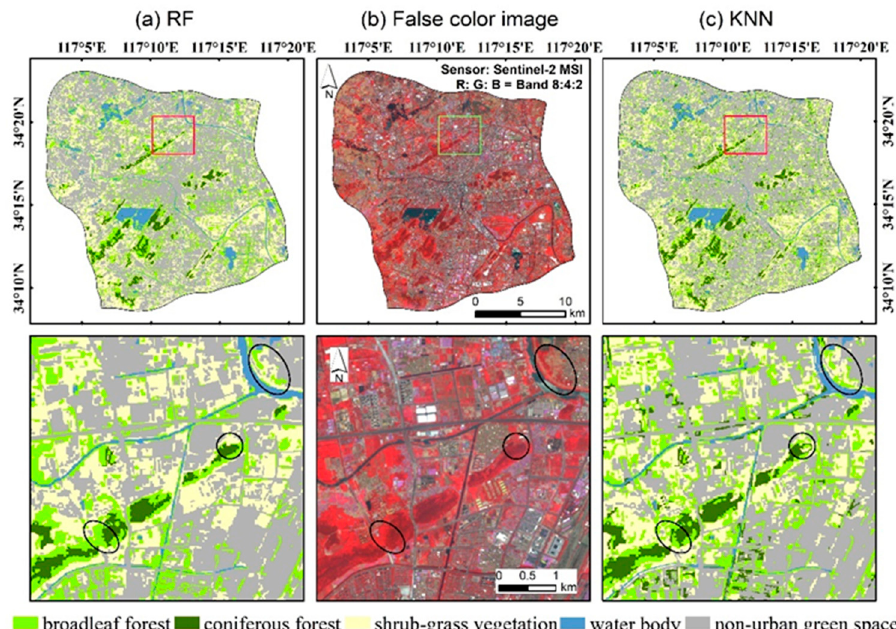
Figure 3. Comparison of green space distribution maps and details produced by two different